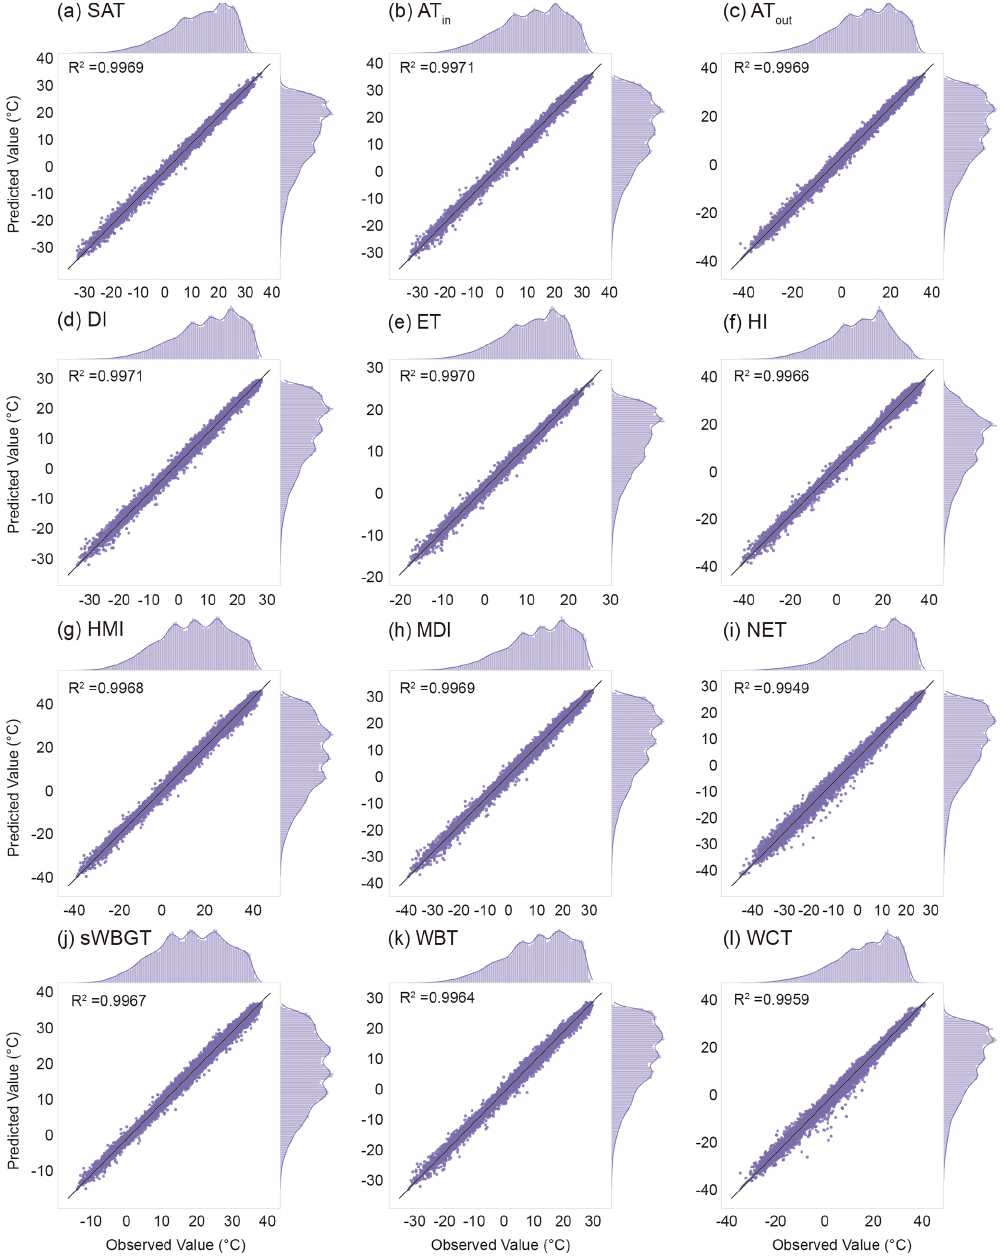
Figure 2. Scatter plots of predictions versus observations of the 12 human thermal indices over the mainland of China during 2003–2020. (a) SAT, (b) AT in , (c) AT out , (d) DI, (e) ET, (f) HI, (g) HMI, (h) MDI, (i) NET, (j) sWBGT, (k) WBT, and (l) WCT.